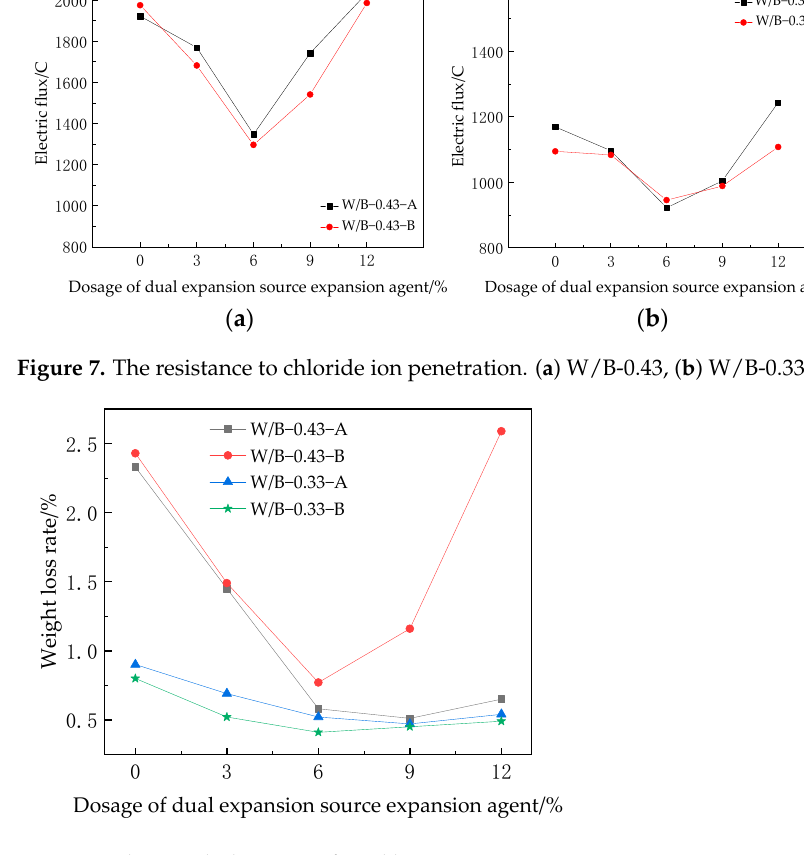
Figure 8. The weight loss rate of steel bars in concrete.